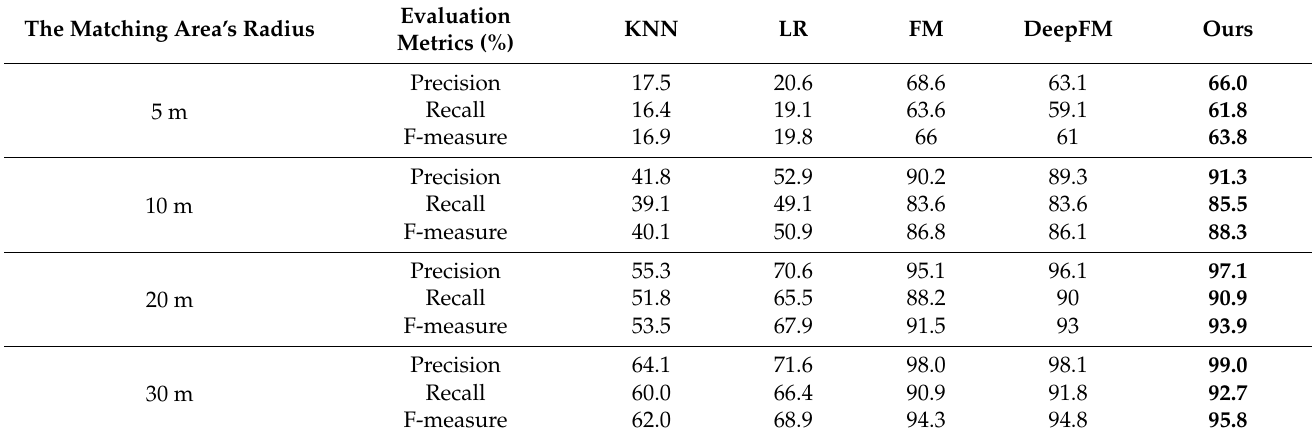
Table 2. The performance evaluation of different classification